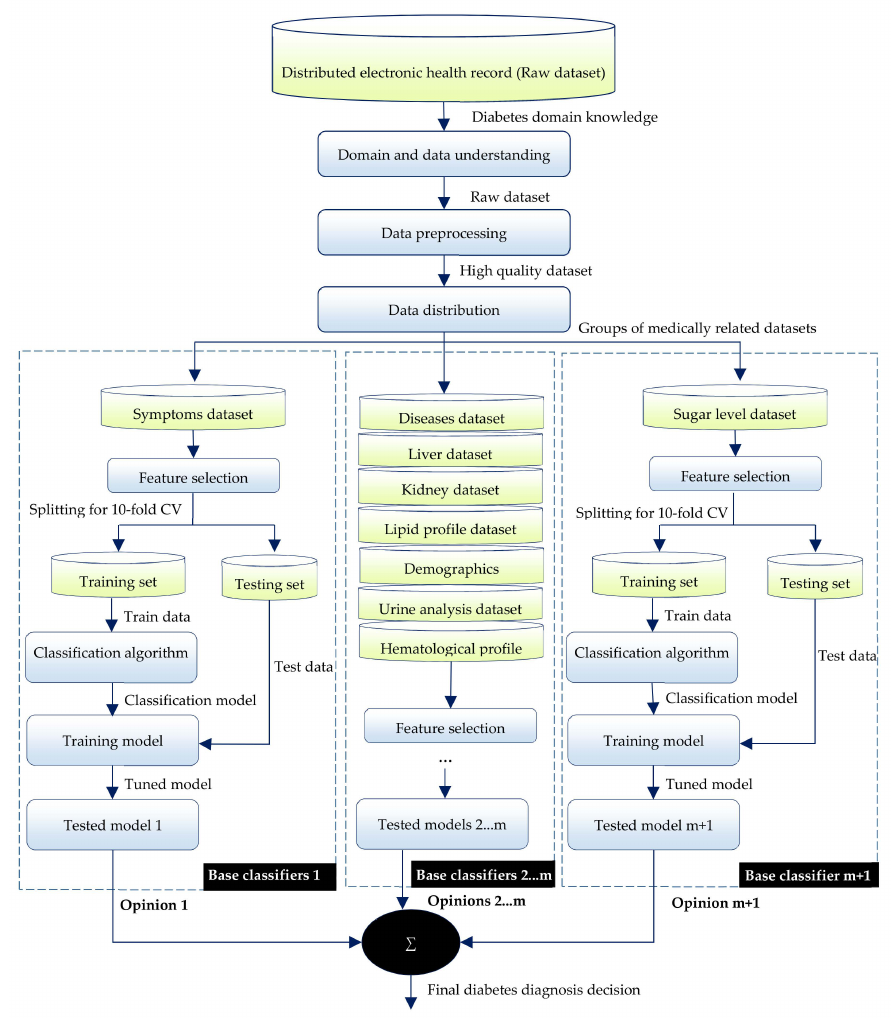
Figure 3. The detailed architecture of the proposed ensemble